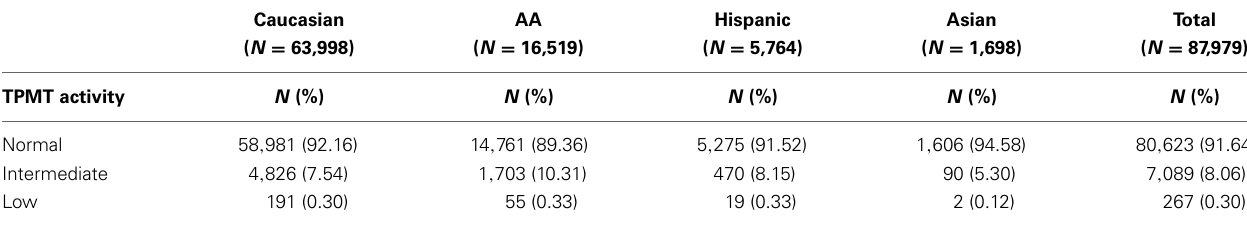
Table 5 | Concordance between the imputed genotypes